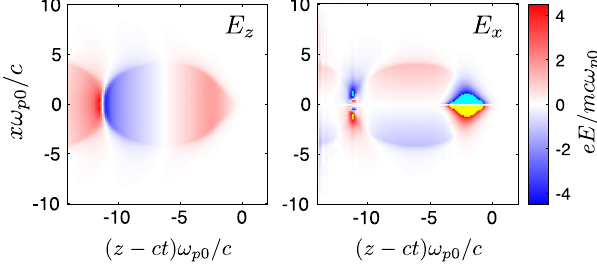
t ¼ 9000 in p 0 ) field and (right) z